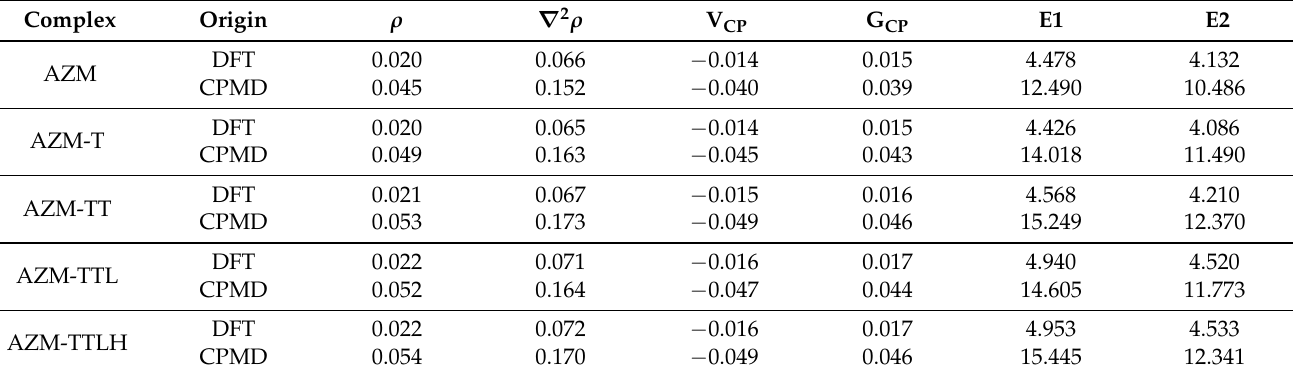
Table 1. AIM-derived properties at BCPs along S1•••O1 path taken from the structures optimized at the M06/aug-cc-pVDZ level of theory and from the CPMD frame for which the S1•••O1 distance was the shortest. E1 and E2 are bond energies based on Espinosa and Vener models, respectively. The dimensions of given quantities are as follows: electron density, ρ BCP , is given in e · a − 3 atomic units 0 and the Laplacian of electron density, ∇ 2 ρ BCP , is in e · a − 5 units. V CP stands for BCP potential energy 0 density and G CP denotes the Lagrangian of kinetic energy density at the